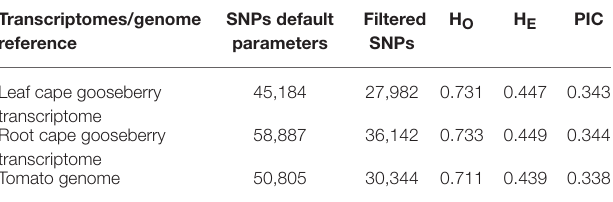
TABLE 4 | Genetic variability estimates of cape gooseberry collection.